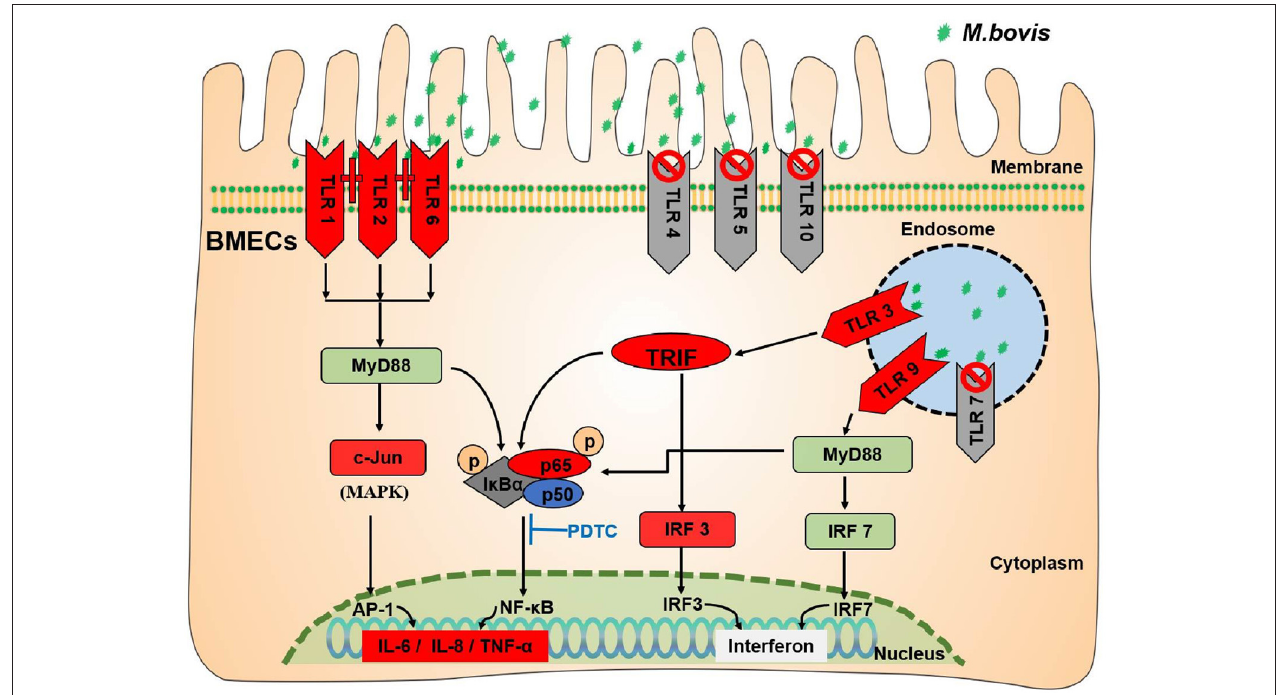
FIGURE 6 | TLRs signaling pathway induced by M. bovis infected BMECs. The green stars indicate M. bovis . The red (TLR1/2/6/3/9; TRIF/IRF3/c-Jun/P-P65; IL-6/IL-8/TNF- α ) in the figure indicates that the expression level increased. The gray (TLR4/5/10/7) indicates that they have no effect during M. bovis infection. The dark gray (P-I κ B α ) indicates that expression decreased during M. bovis